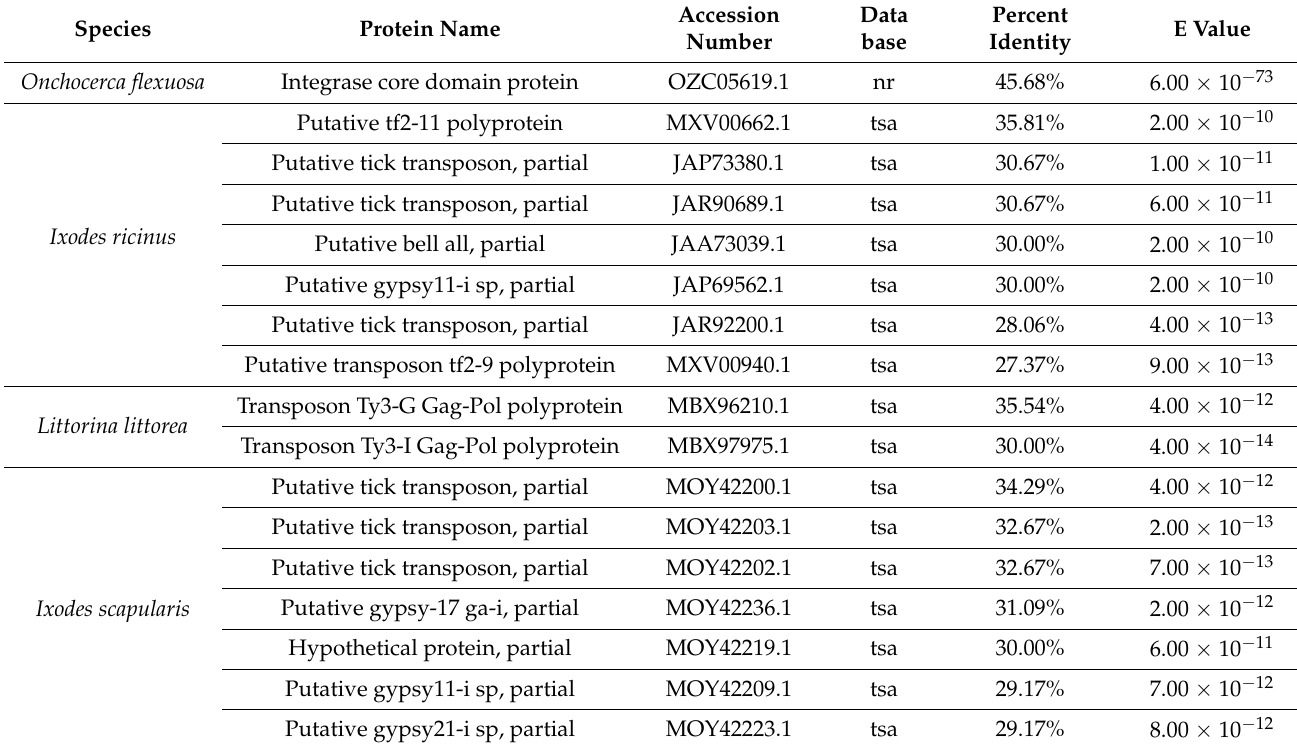
Table A4. Nephrozoa (non-boreoeutherian) genomes with similarity to ERVK integrase based on BLASTp